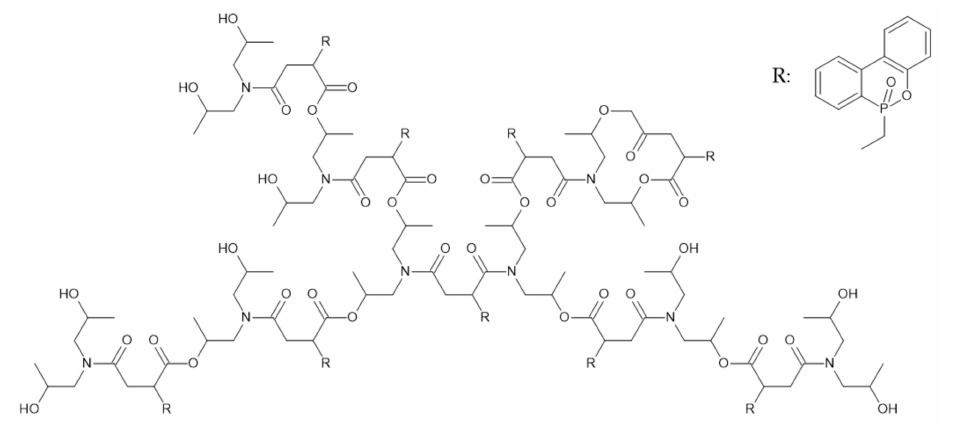
Figure 17. The structure of the ITA-HBP